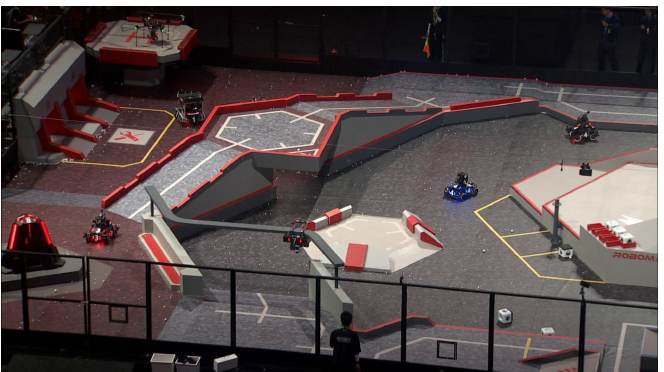
Figure 9. Example figure of the dataset. There are four objects to be identified in the figure. They are car, base, and watcher, and armor is among the above objects.